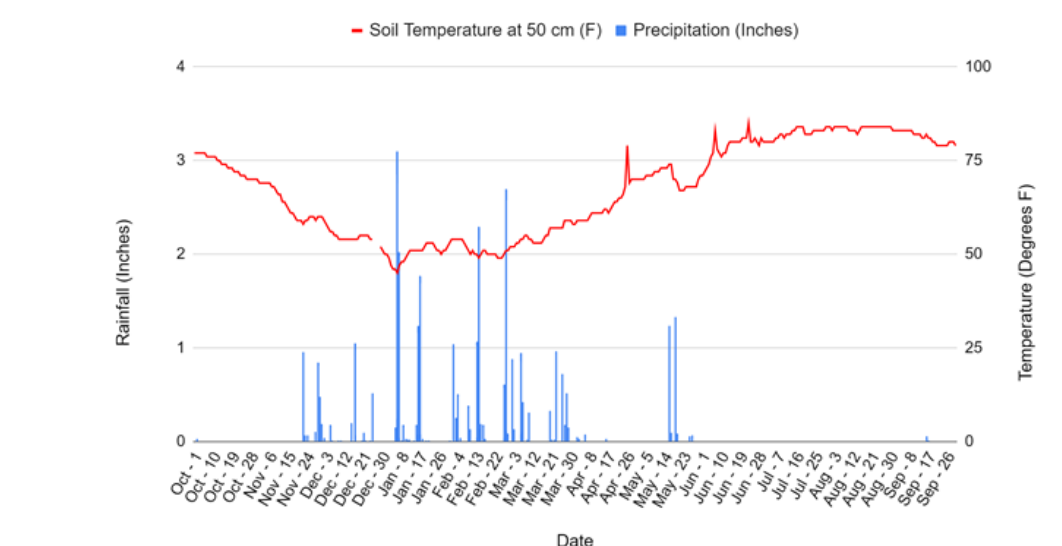
Figure A5. Rainfall and soil temperature at 50cm at Russell Ranch from October 2018 to October 2019. Data taken from http://atm.ucdavis. edu/weather/uc-davis-weather-climate-station (last access: 13 January 2022).